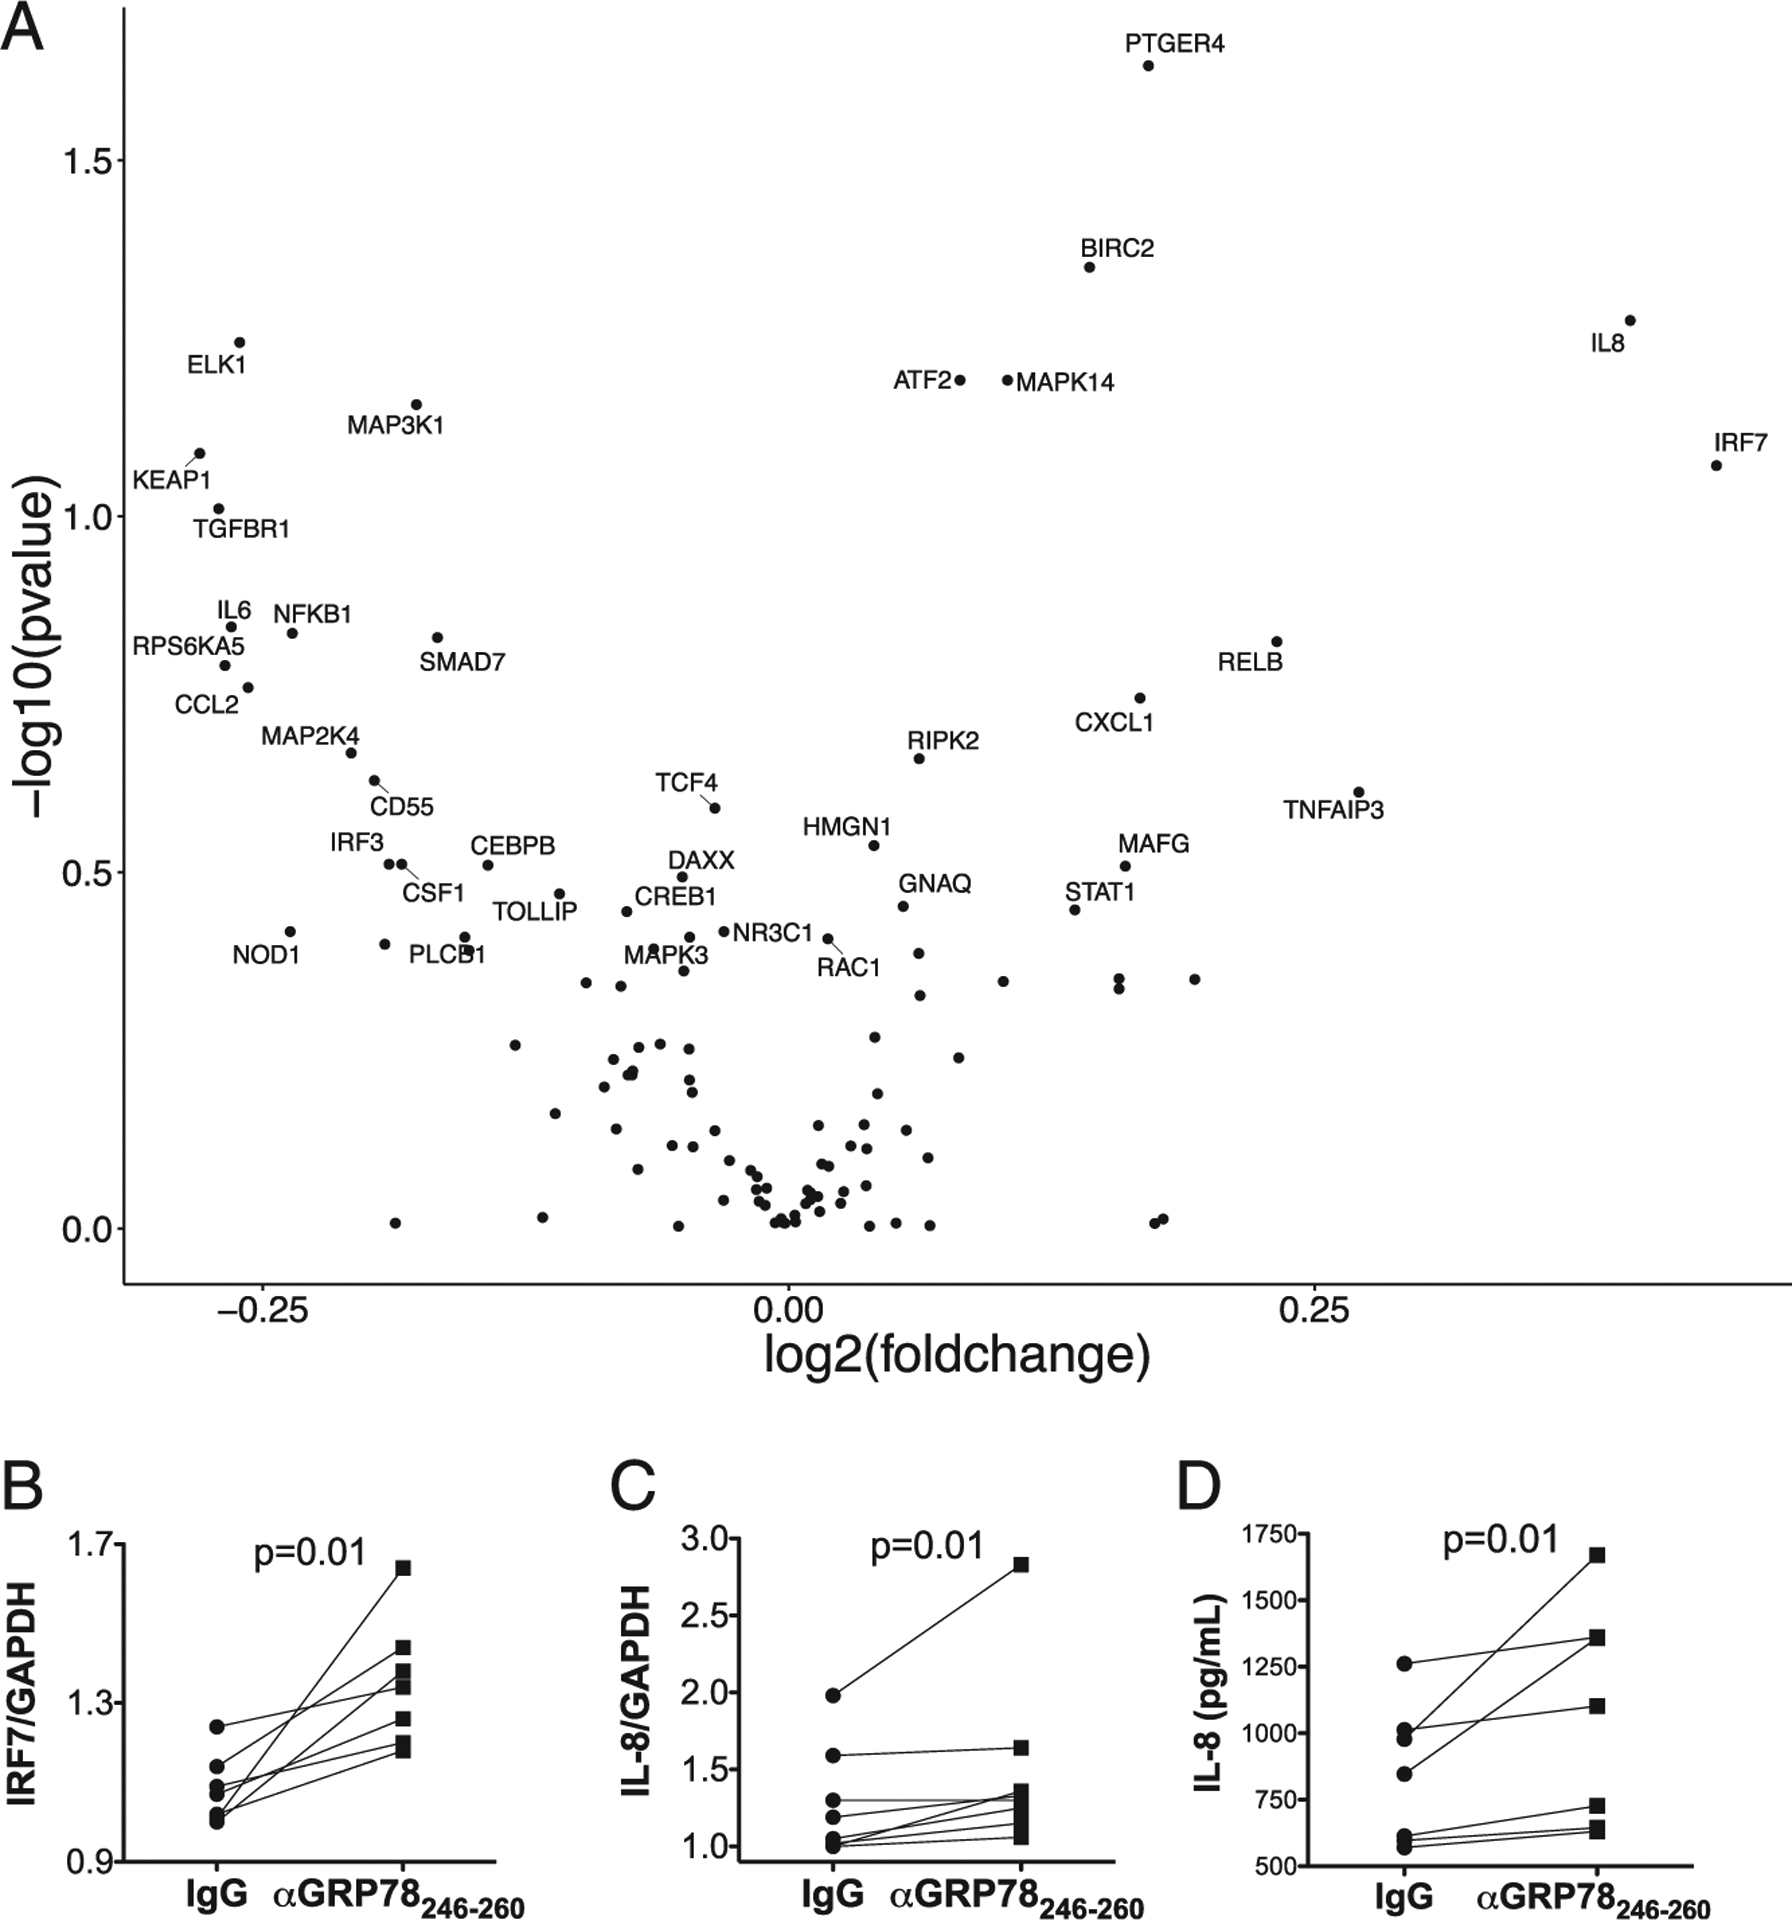
Anti-GRP78aa 246–260 autoantibodies altered HAEC gene expression.(A) Volcano plot shows fold changes (log values) in levels of selected HAECs gene expressions, measured by NanoString assay (NanoString Human Inflammatory Panel), versus significance (p values), in HAECs treated with anti-GRP78aa 246–260 autoantibodies isolated from patient plasma. Changes are relative to measures in concurrent HAECs treated with normal IgG (n = 4 pairs). Validations of NanosString assay by RT-PCR confirmed IRF-7 mRNA (B) and IL-8 mRNA (C) were increased in HAECs by treatment with anti-GRP78aa 246–260 autoantibodies, again compared with cells treated with control IgG. (D) IL-8 concentrations, measured by ELISA, were greater in supernatants of HAECs treated with anti-GRP78aa 246–260 Abs compared with those treated with normal IgG control.